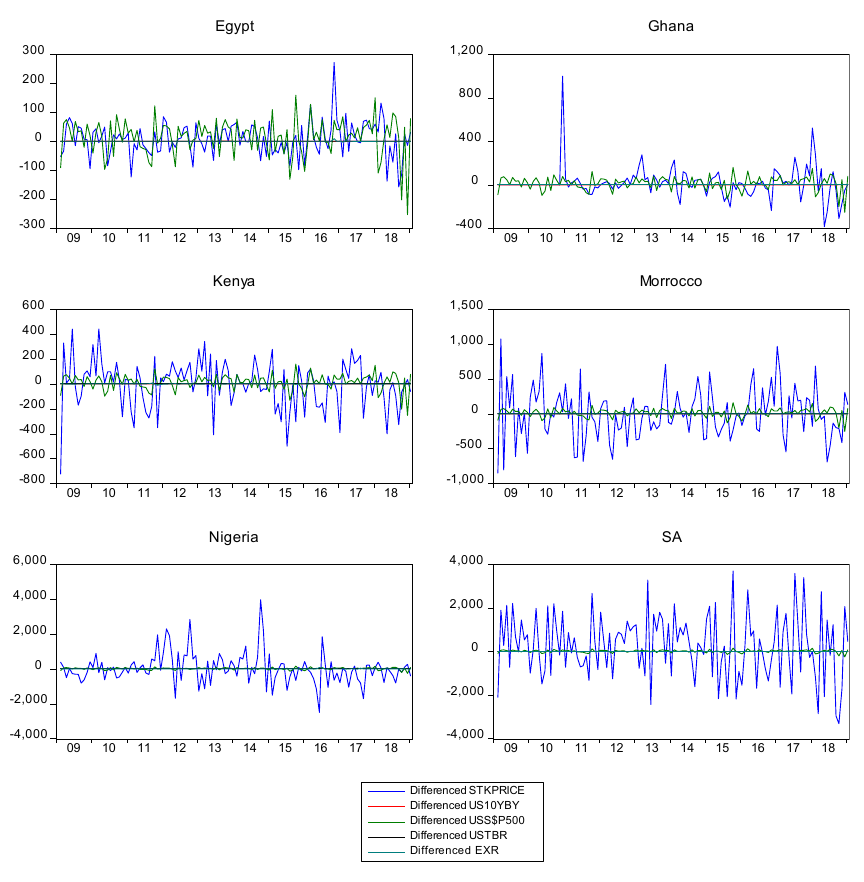
Figure 1. Country-specific first difference plot of the studied